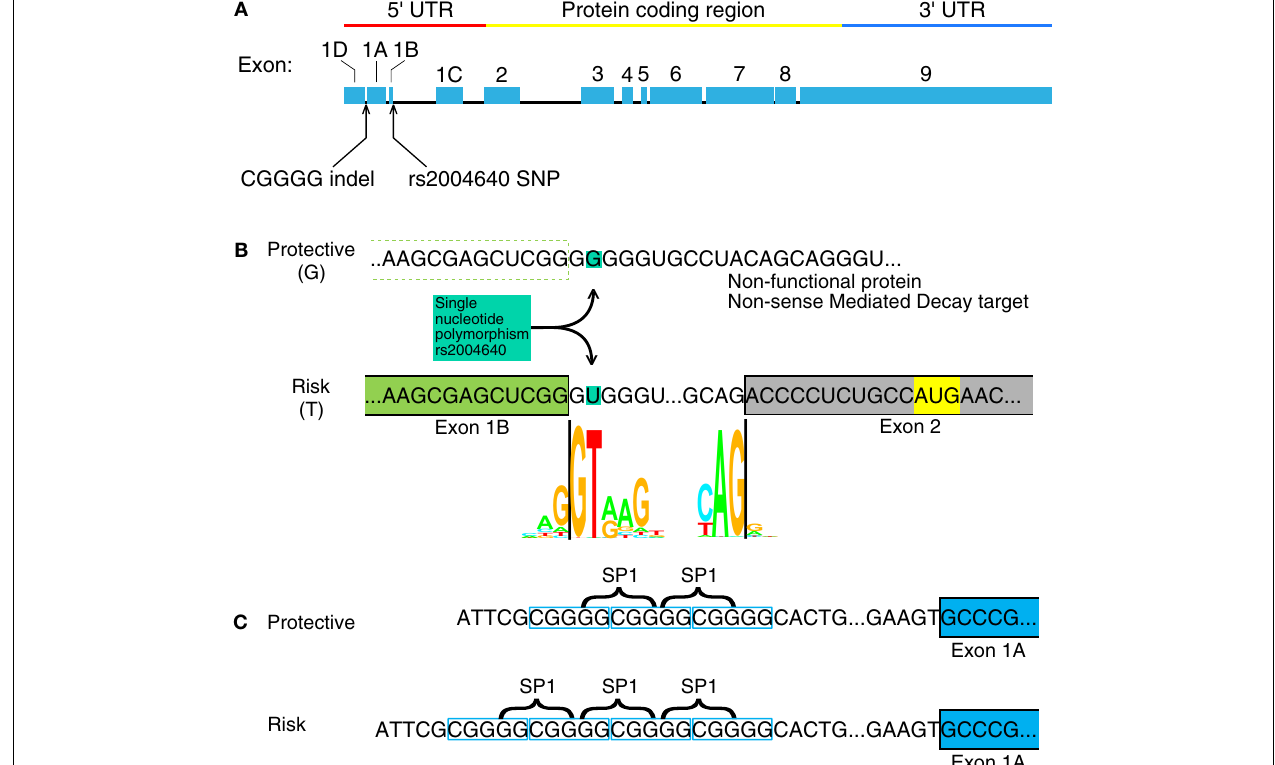
FIGURE 1 | Interferon regulatory factor 5 mRNA and the position of the rs2004640 SNP and CGGGG indel . (A) rs2004640 is at the splice acceptor site for exon 1B, and the CGGGG indel is 64bp upstream from the transcription start site for exon 1A.The genomic region of IRF5 is drawn to scale, but with introns reduced in size 10:1.The protein coding and untranslated regions are shown above. Only one first exon is used per RNA transcript; therefore each first exon corresponds to the untranslated region for that transcript. (B) The position of the rs2004640 SNP on pre-mRNA. Before splicing, the messenger RNA has either a U (encoded by the riskT allele) or G.The colored letters shown in theWebLogo (the nucleotide stacks of varying heights represent the consensus recognition sites for the spliceosome.The height of the stack represents how often those nucleotides are found at that